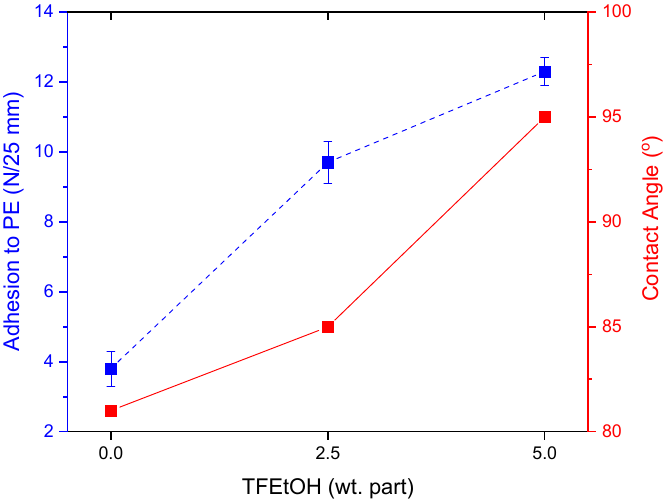
Figure 9. Adhesion of PSA to PE and the contact angle for a PSA/water system in relation to the fluorotelogen concentration in the PSA sample (PSA with 6 wt. parts of L9033 and syrups containing 30 wt. parts of LMA).